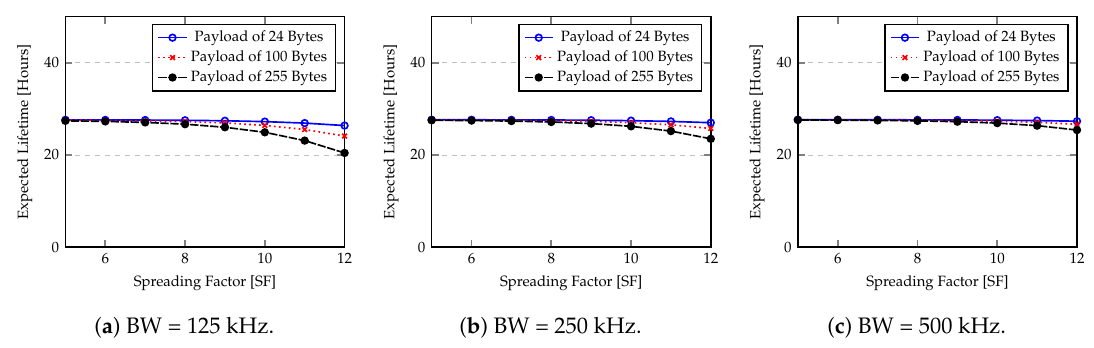
Figure 13. Expected battery lifetime for Arduino node.